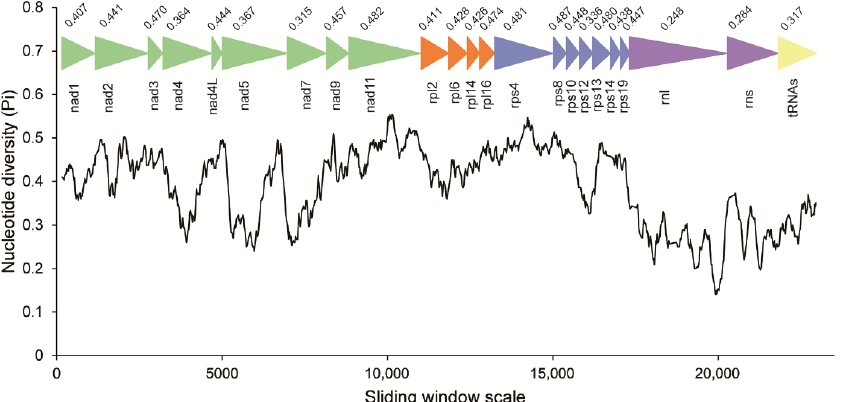
Figure 3. Sliding window analysis of nucleotide diversity between the MRO genes of Cepedea longa and Proteromonas lacertae . The black curved line represents the value of nucleotide diversity. Gene names, boundaries and average nucleotide diversity values are shown above the line.